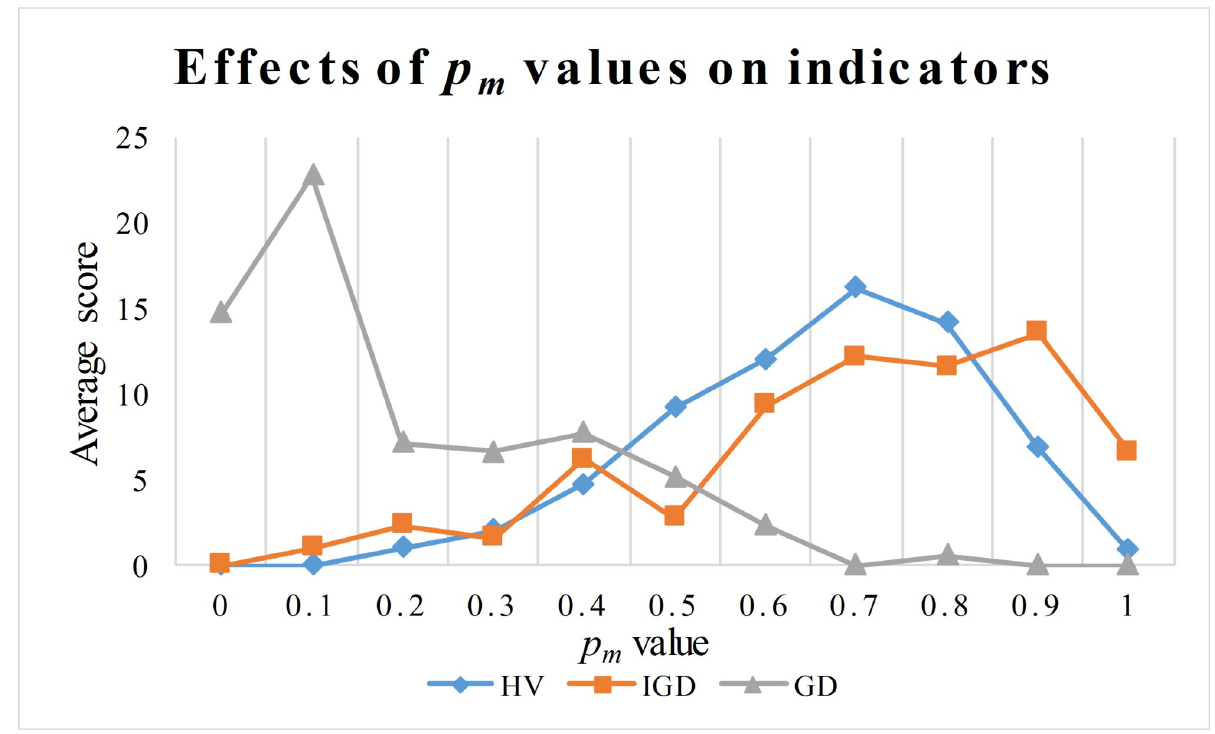
Fig 4. Effects of p m values on the performance of